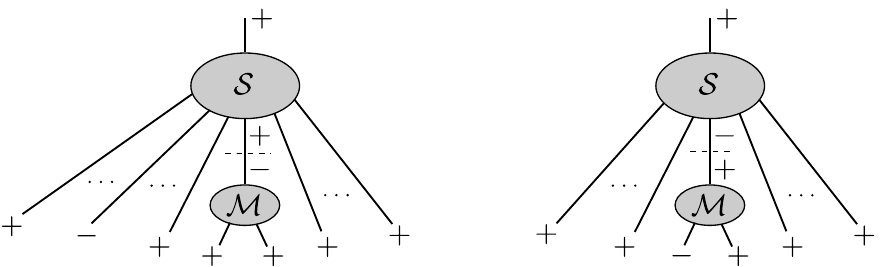
Figure 2 . The two types of pole contributions in the recursion of the N − 1 MHV static-patch amplitudes S (1 + , . . . , i − , . . . , n + ; +) via eq. (4.20). In both cases, the amplitude reduces to